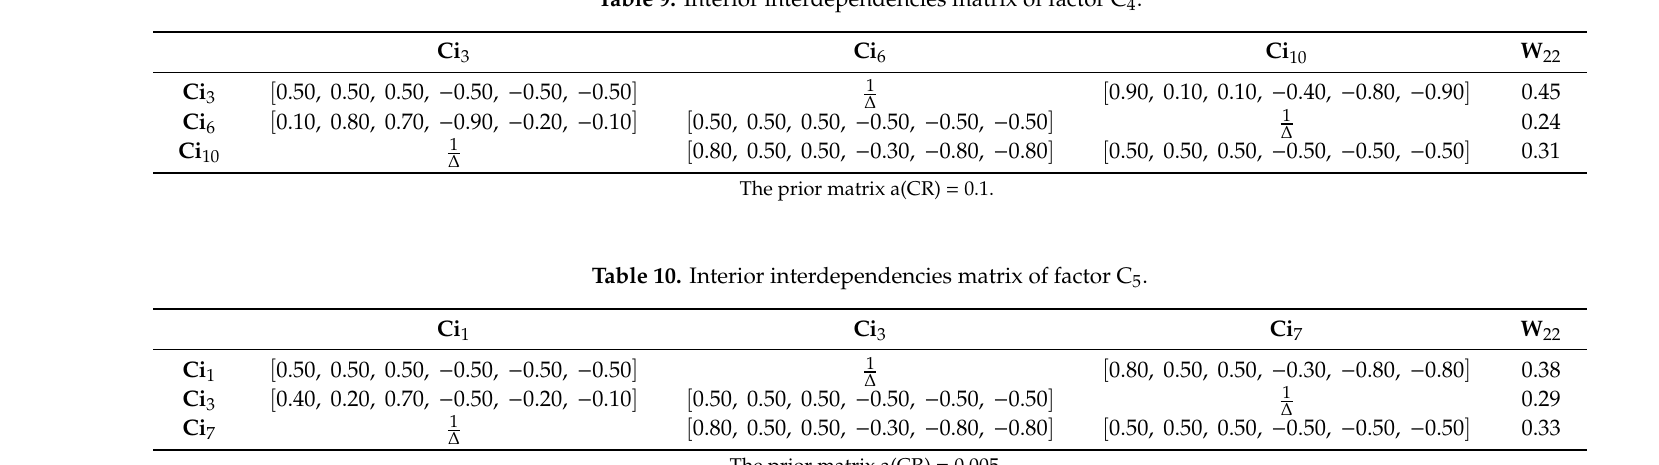
Table 9. Interior interdependencies matrix of factor C 4 .